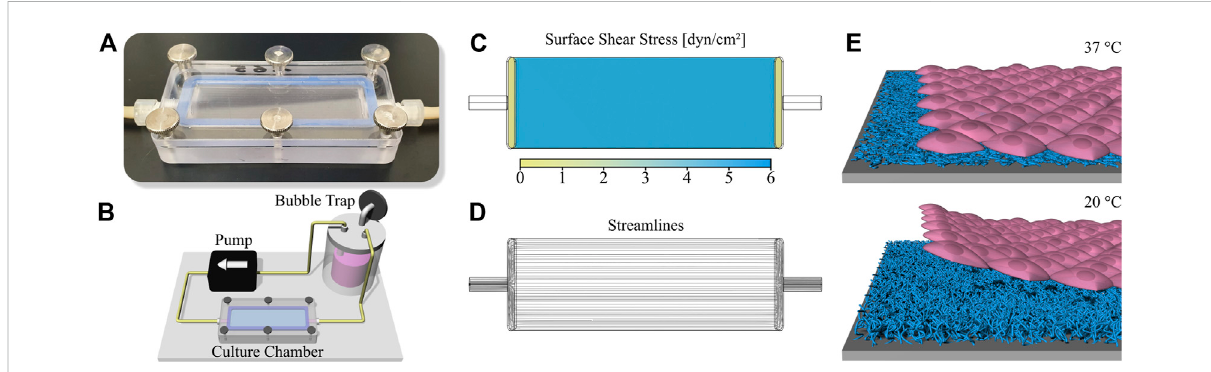
FIGURE 1 Setup for dynamic cell culture and cell sheet fabrication. (A) Photography of the slide culture chamber (channel height 150 µm) and (B) illustrationof the circuit for dynamic cell culture including medium reservoir/bubble trap, peristaltic pump and culture chamber. Characterization of the comprised fl ow channel via Computational Fluid Dynamics (CFD) simulation showing (C) surface shear stress and (D) fl ow streamlines. (E) Schematicillustrationof cell sheet fabrication using athermoresponsivePGE-coating on polystyrene (PS). The polymer coating is cell adhesive at a temperature of 37 ° C while changing to a cell repellent state at 20 ° C, therefore initiating the enzyme-free detachment of con fl uent cell sheets after the temperature